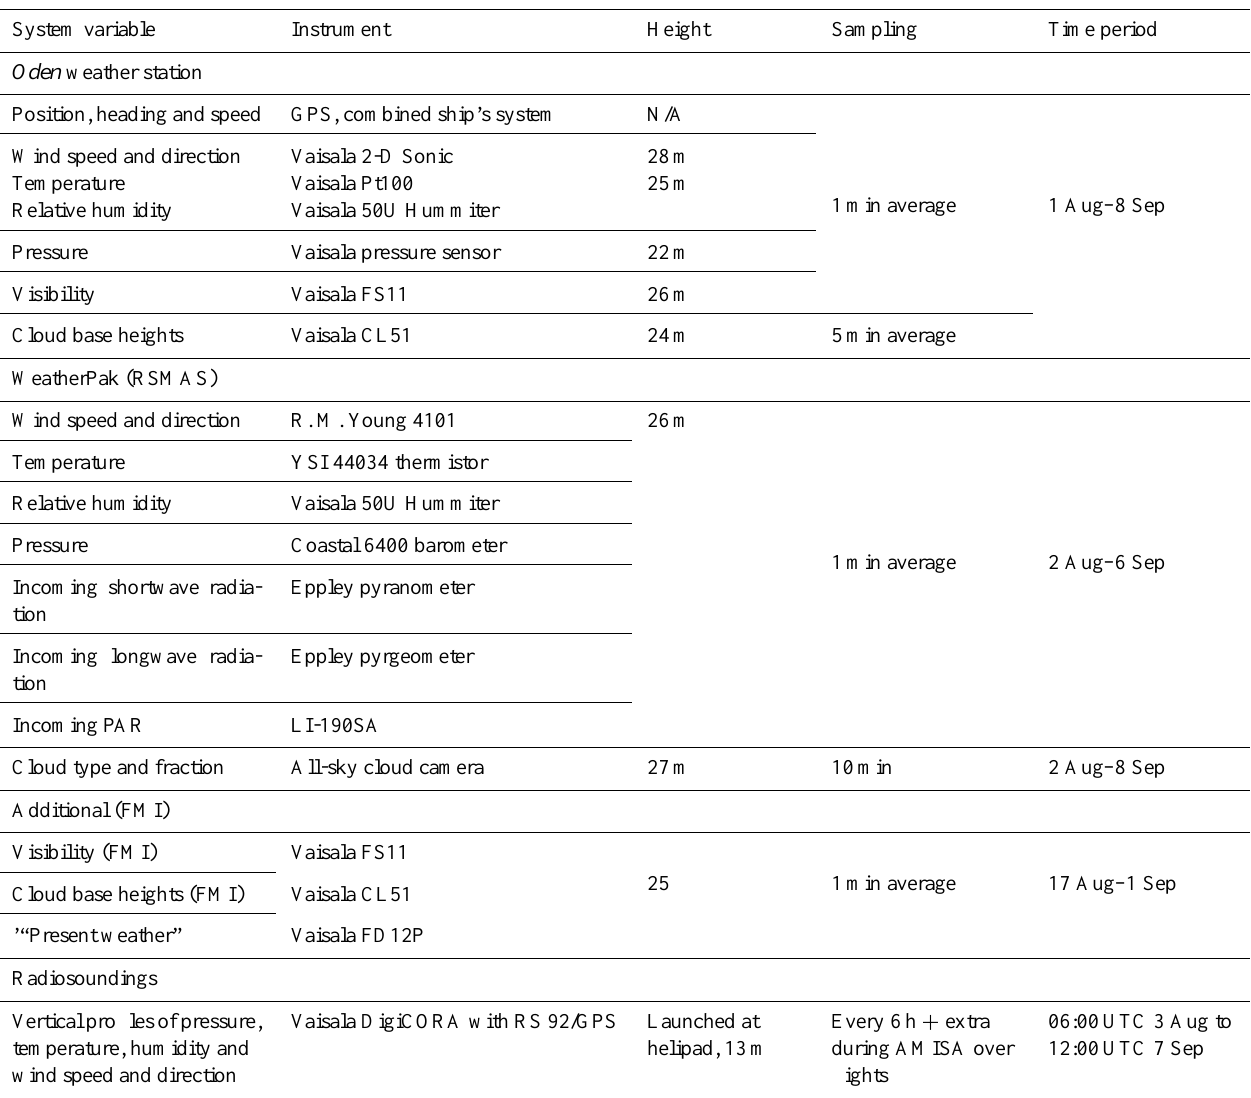
Table A1. List of basic meteorological instruments on board Oden . Two weather stations were operated: one supplied by the Rosenstiel School of Marine and Atmospheric Science (RSMAS) and one permanently on board. Additional sensors were deployed by the Finnish Meteorological Institute